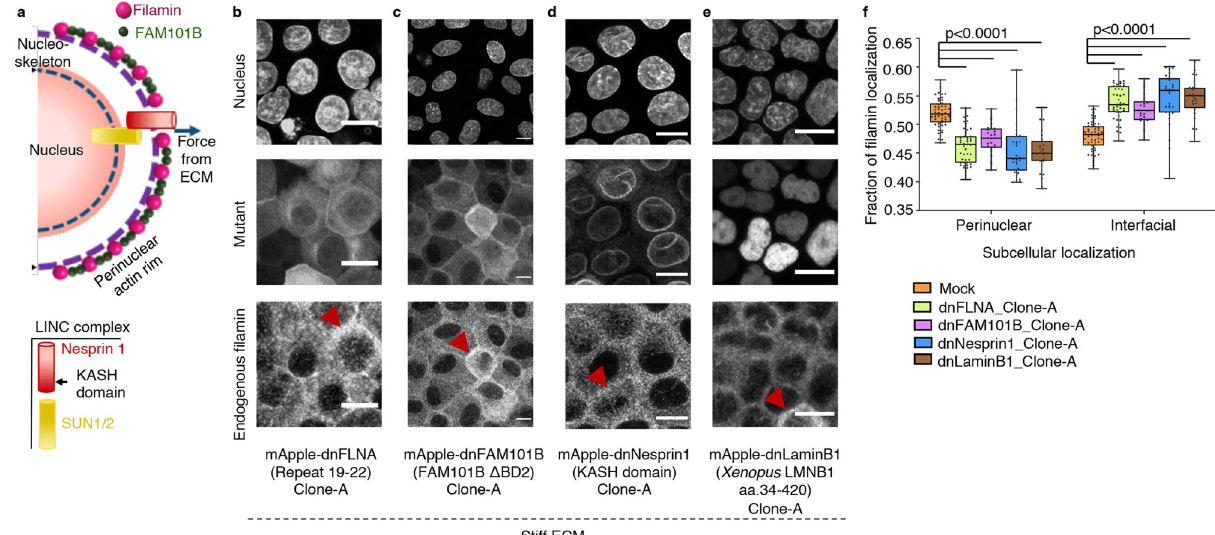
Fig. 4 Interaction with perinuclear cytoskeleton determines perinuclear fi lamin localization. a Schematic representation for fi lamin structure, depicting its interactions with FAM101B and F-actin. The fi lamin-FAM101B-actin localization at perinuclear space is enabled by the complex ’ s interaction with LINC complex, which responds to extracellular force cues. b – e Immuno fl uorescence images of mApple-dnFLNA-MDCK ( b ), MDCK-mApple-dnFAM101B ( c ), mApple-dnNesprin1-MDCK ( d ) and mApple-dnLaminB1-MDCK ( e ) stained for fi lamin. Red arrowheads indicate interfacial fi lamin localization on stiff ECM. Scale bars = 10 μ m. f Box-and-whiskers plot depicting the fraction of fi lamin mean fl uorescence intensity at perinuclear and interfacial regions, per cell, on stiff (90 kPa) ECM; n = 56 (mock), 43 (dnFLNA), 26 (dnFAM101B), 30 (dnNesprin1) and 24 (dnLaminB1) cells over three independent experiments. Statistical signi fi cance was assessed using an unpaired Student ’ s t -test with Welch ’ s correction (two-tailed). Signi fi cance values: p = 2.56898e − 16 (mock- dnFLNA), 1.13087e − 09 (mock-dnFAM101B), 6.35474e − 09 mock-dnNesprin1), 6.62199e − 10 (mock-dnLaminB1). For boxplots, the centre line denotes the median, the box displays the interquartile range, whiskers indicate the range not including outliers (1.5× interquartile range). Source data ( b – e ) are provided as a Source Data fi